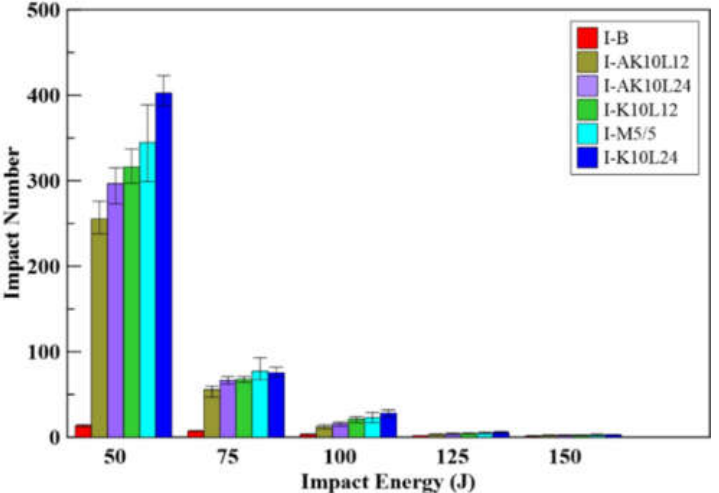
Figure 9. Impact energy−number relationships of the benchmark and KFRC specimens.